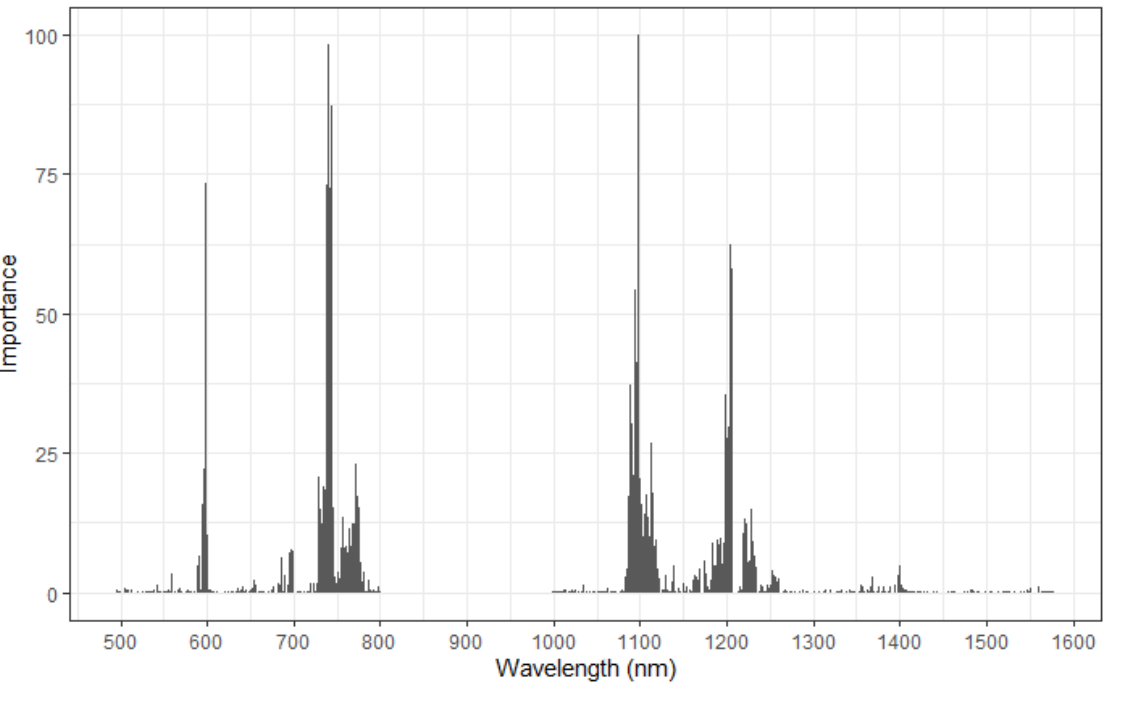
Figure 4. Variable importance for combination of visible (470.5–800.5 nm) and short-wave infrared (1000.5–1600.5 nm) spectra using random forest modelling to identify bovine and ovine organs by type.